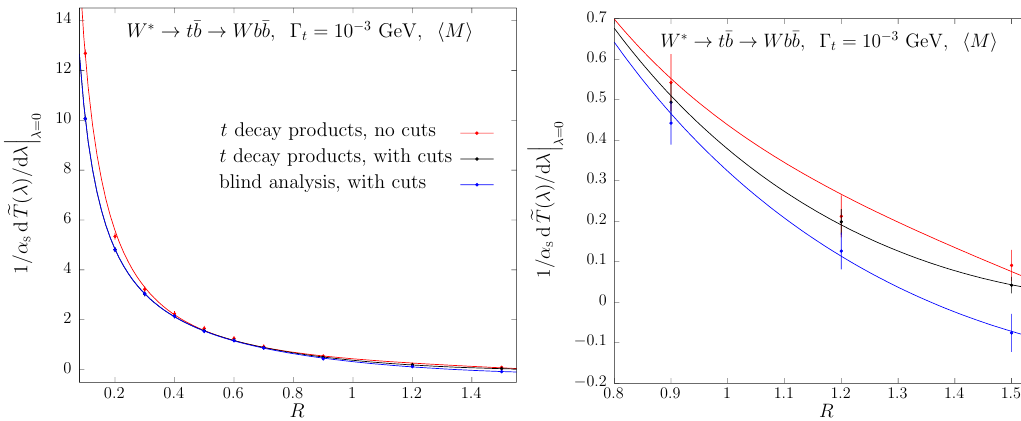
Figure 6 . R dependence of the slope of e T ( (cid:21) ) for the average reconstructed mass h M i , at (cid:21) = 0, computed with (cid:0) t = 10 (cid:0) 3 GeV. The results obtained by reconstructing the b jet using only the top-decay products, without imposing any cut and with the cuts of section 4.1, are shown in red and in black, respectively. In blue, the results for a blind analysis with cuts. The solid lines represent (cid:12)ts of parametric form a=R + b + c R + d R 2 . The black and the blue curves are almost completely overlapping and are indistinguishable in the plot on the left. A blowup of the high- R region is illustrated in the plot on the right.